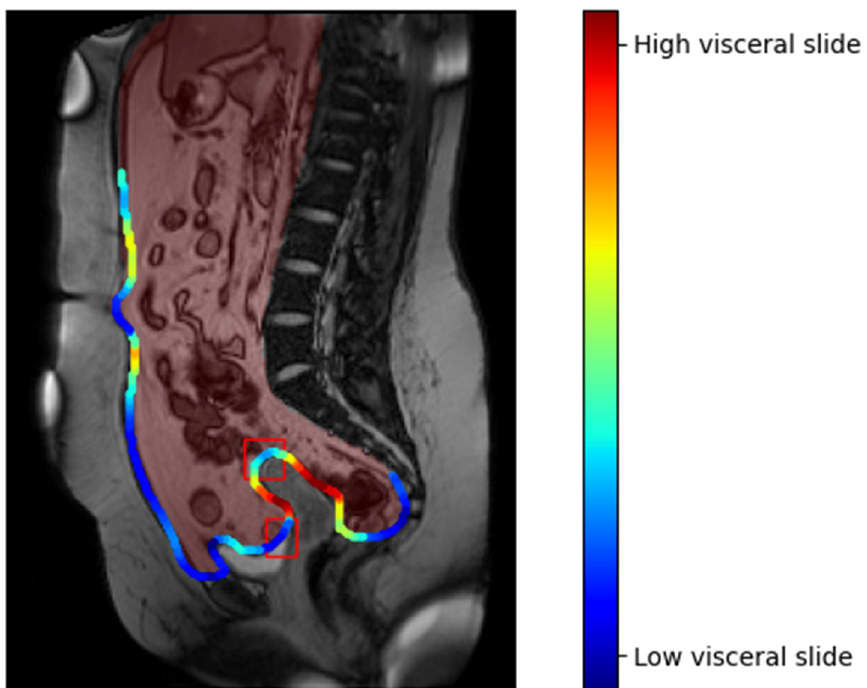
Figure 3. Computationally estimated visceral slide on CineMRI along the contour of the peritoneal cavity. The red mask is the output of a deep learning system that segments the peritoneal cavity, the red boxes show the reference annotations by a radiologist. Low visceral slide (blue) corresponds to locations suspicious for adhesions. Figure adapted from https://github.com/DIAGNijmegen/adhesion_detection. Accesed on 08 Feb 2022